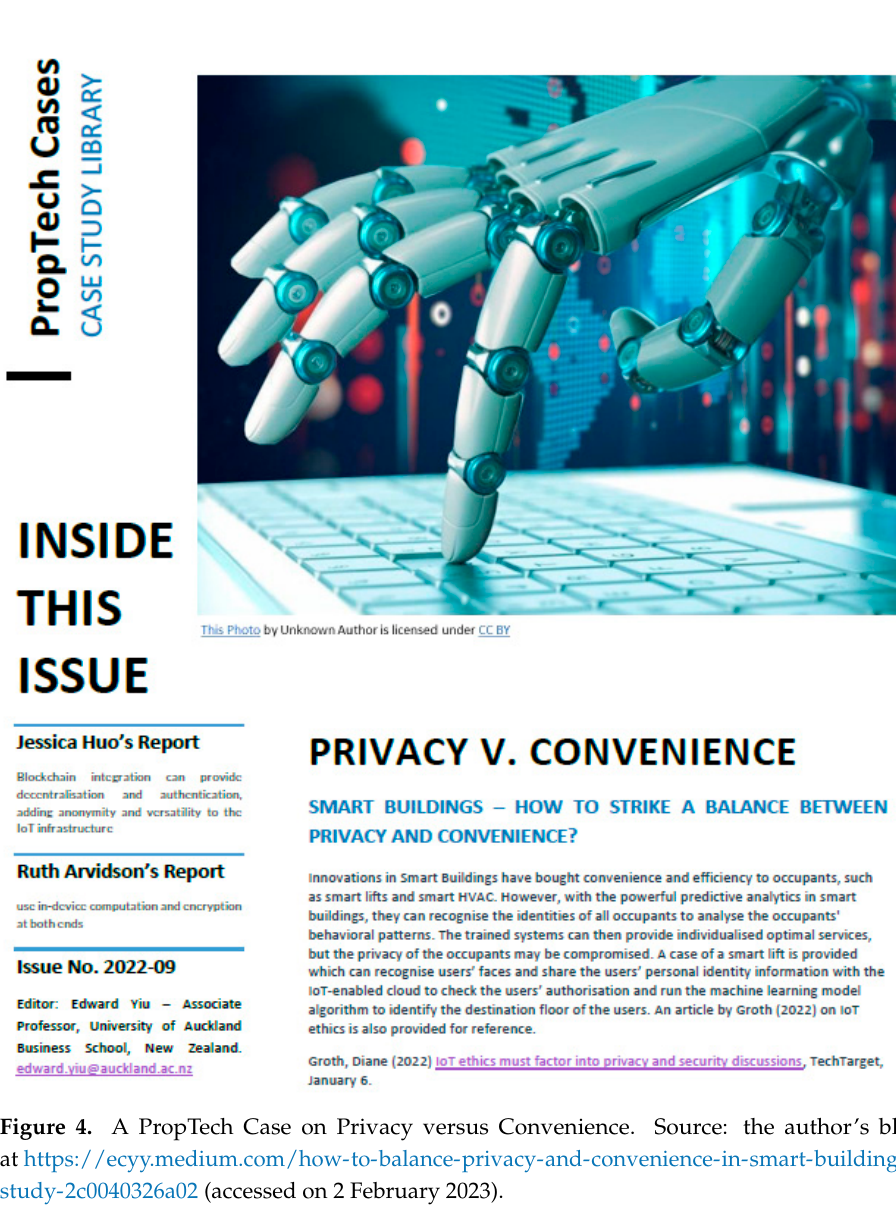
Figure 4. A PropTech Case on Privacy versus Convenience. Source: the author’s blog page at https://ecyy.medium.com/how-to-balance-privacy-and-convenience-in-smart-buildings-a-case- study-2c0040326a02 (accessed on 2 February 2023).